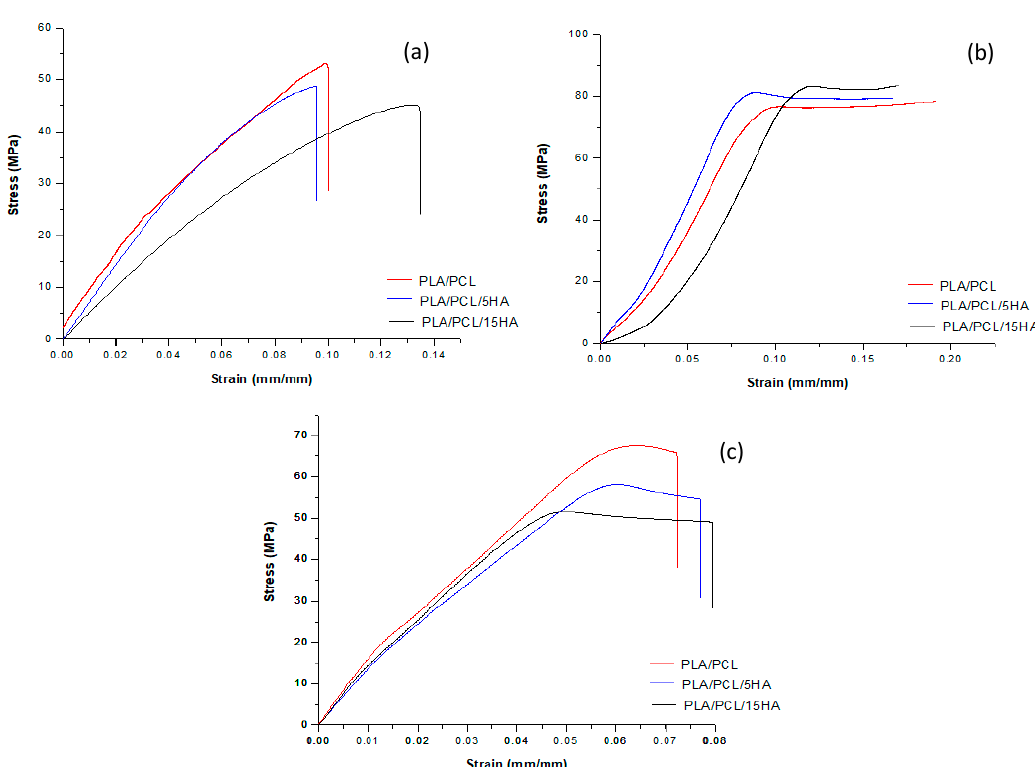
Figure 9. Representative stress–strain curve of the ( a ) filament tensile testing data; ( b ) specimen compression testing; and ( c ) specimen tensile testing for each composition.